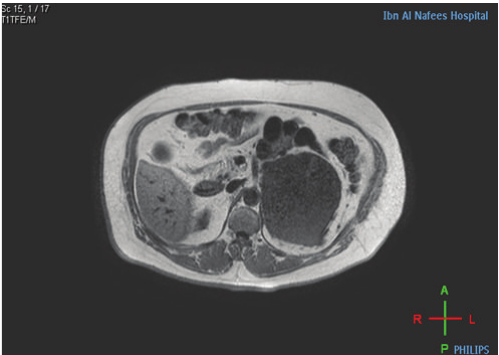
Figure 1: In phase axial image: 11 × 12 × 13 cm well defined hypointense lesion anterior and superior to Lt. kidney abutting the renal vessels and Lt. crus of diaphragm with no signal voids indicating calcification and no hyper intense signal indicating fat content or hemorrhage.